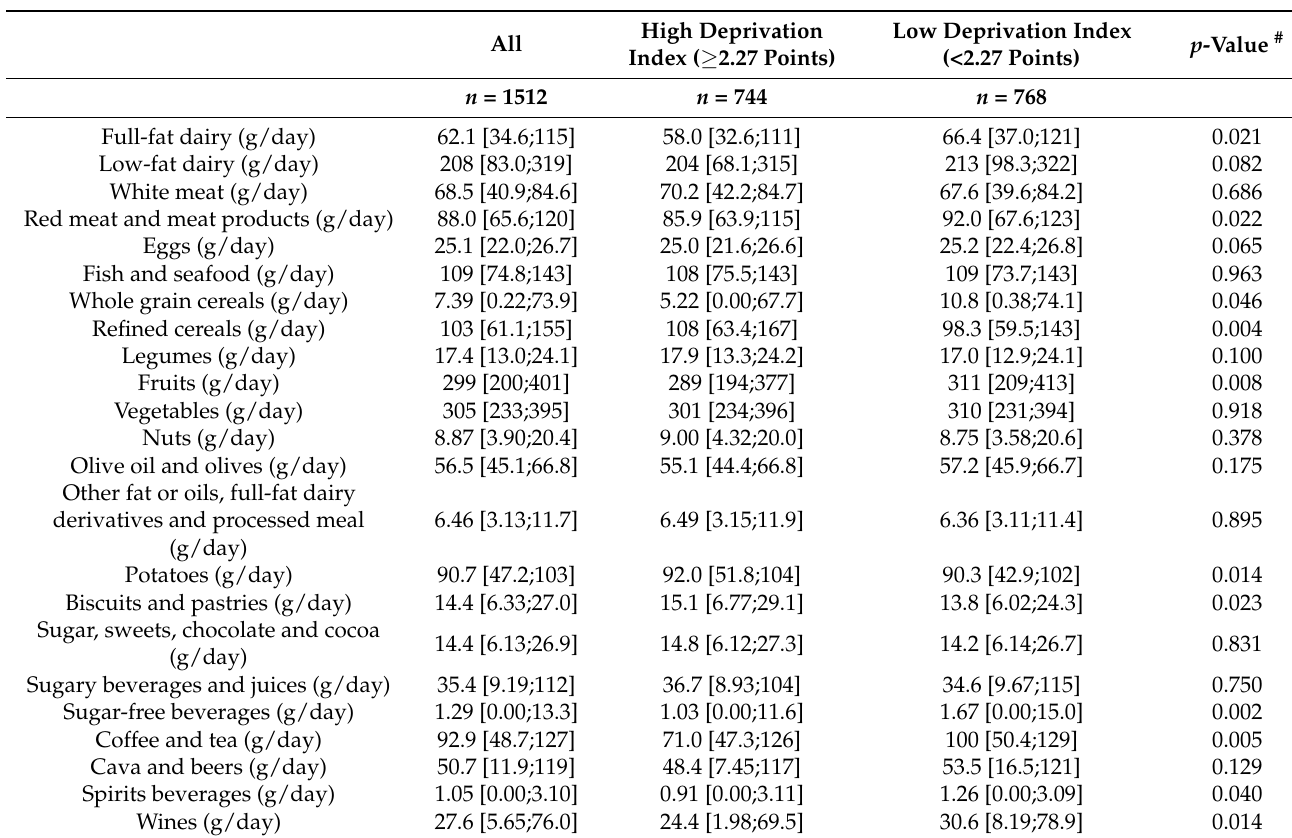
Table 2. Food consumption of participants according to Composite Socioeconomic Index (CSI) categories. High Deprivation All Index ( ≥ 2.27